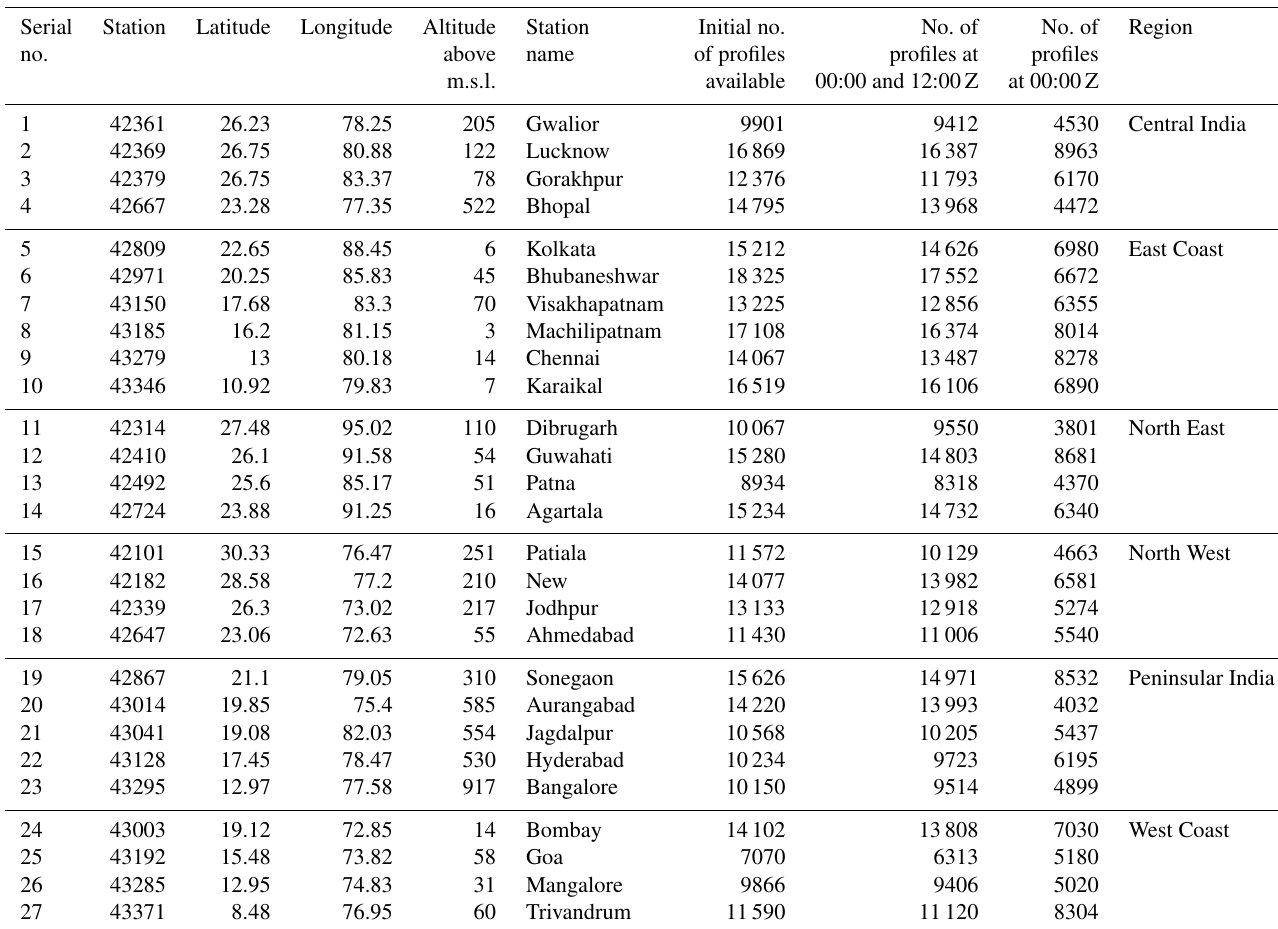
Table A1. Details of the dataset